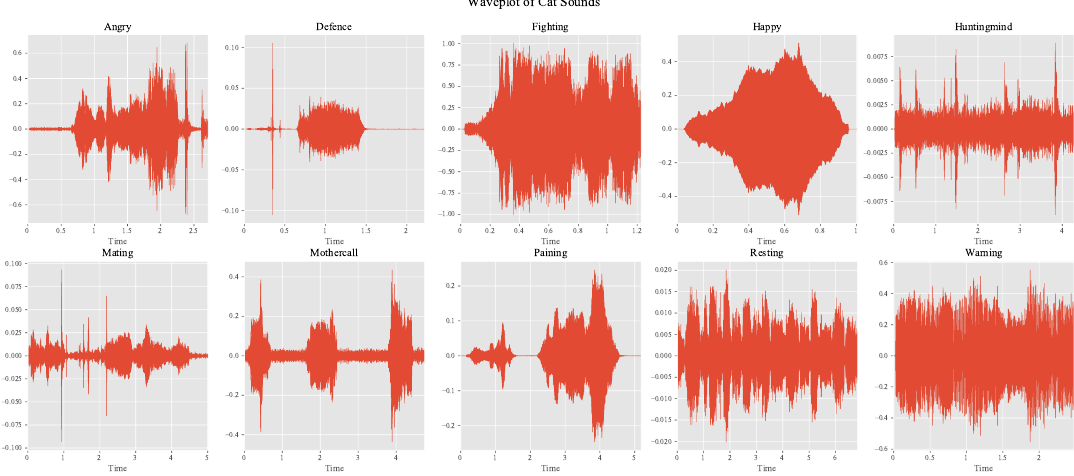
Figure 2. Waveform visualization of 10 data sample taken from each class of CatSound